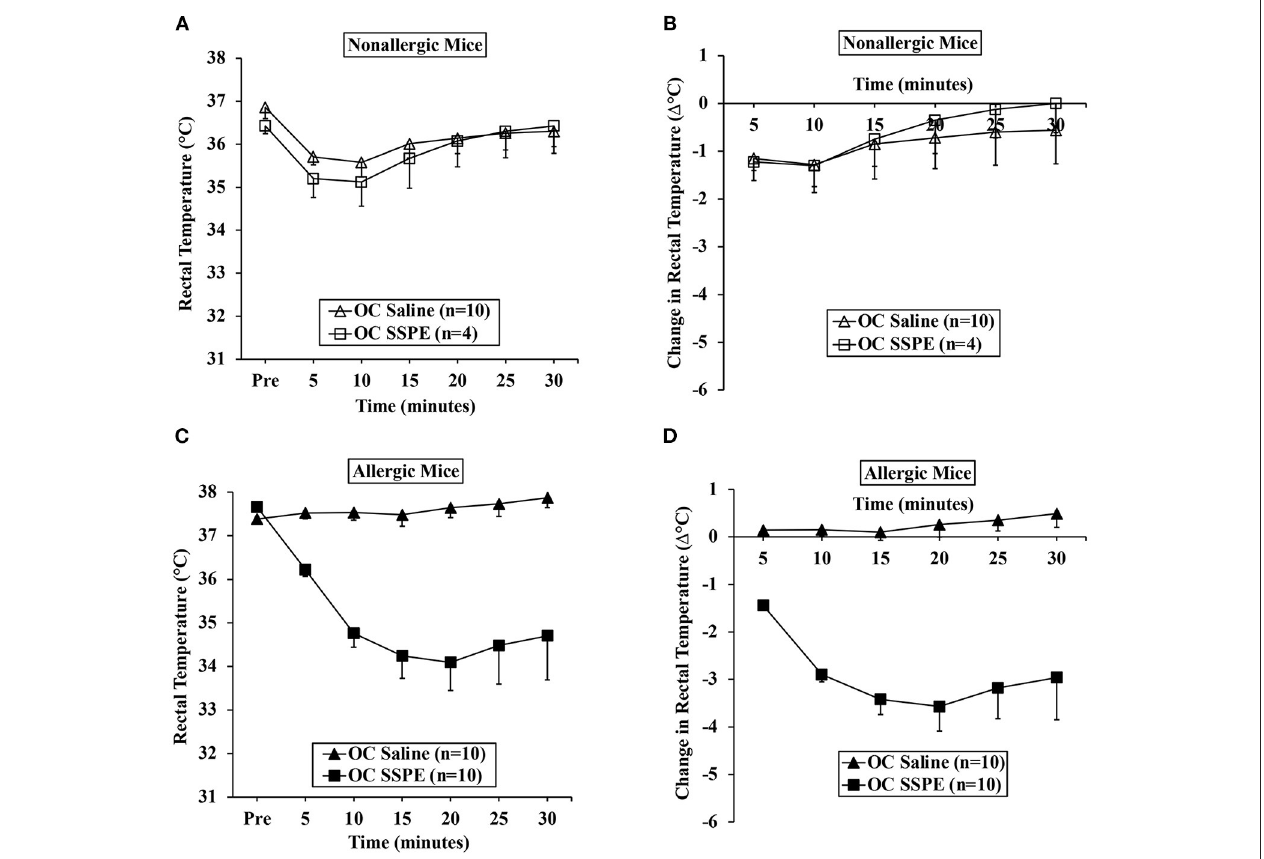
FIGURE 2 | Transdermal exposure to durum wheat (genomes AABB) SSPE sensitized Balb/c mice for anaphylaxis upon oral challenge. Mice exposed to SSPE or to saline were orally challenged (OC) as described in MATERIALS AND METHODS. (A) Rectal temperatures ( ◦ C) at indicated time points in non-allergic mice challenged with SSPE or saline. (B) Change in rectal temperature ( 1 ◦ C) at indicated time points in non-allergic mice challenged with SSPE or saline. (C) Rectal temperatures ( ◦ C) at indicated time points in allergic mice challenged with SSPE or saline. (D) Change in rectal temperature ( 1 ◦ C) at indicated time points in allergic mice challenged with SSPE or